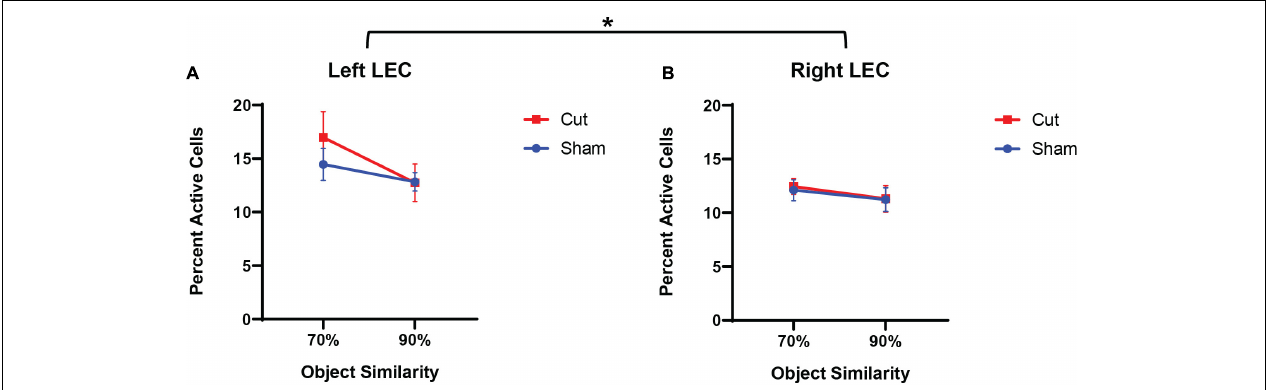
FIGURE 5 | Percentage of active cells, as determined by expression of the immediate early gene Arc , in the Left (A) and Right (B) Lateral Entorhinal Cortex (n’s: Sham = 12 ). Quantified Arc expression in the left LEC was higher than the right hemisphere ( F [ 1 , 51 ] = 4.283, p = 0.044), but there was no effect of surgical condition or sex. Activity was lower in both hemispheres and across surgical conditions for 90% similarity trials compared to 70% similarity ( F [ 1 , 55 ] = 5.8482, p = 0.019). * indicates a significant effect ( p ≤